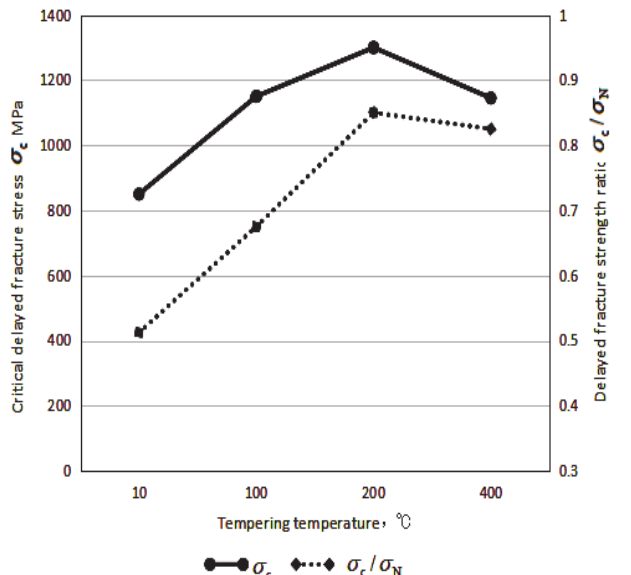
Figure 5: Variation of clinical fracture stress and delay fracture ratio of the experimental materials along with the changes of tempering